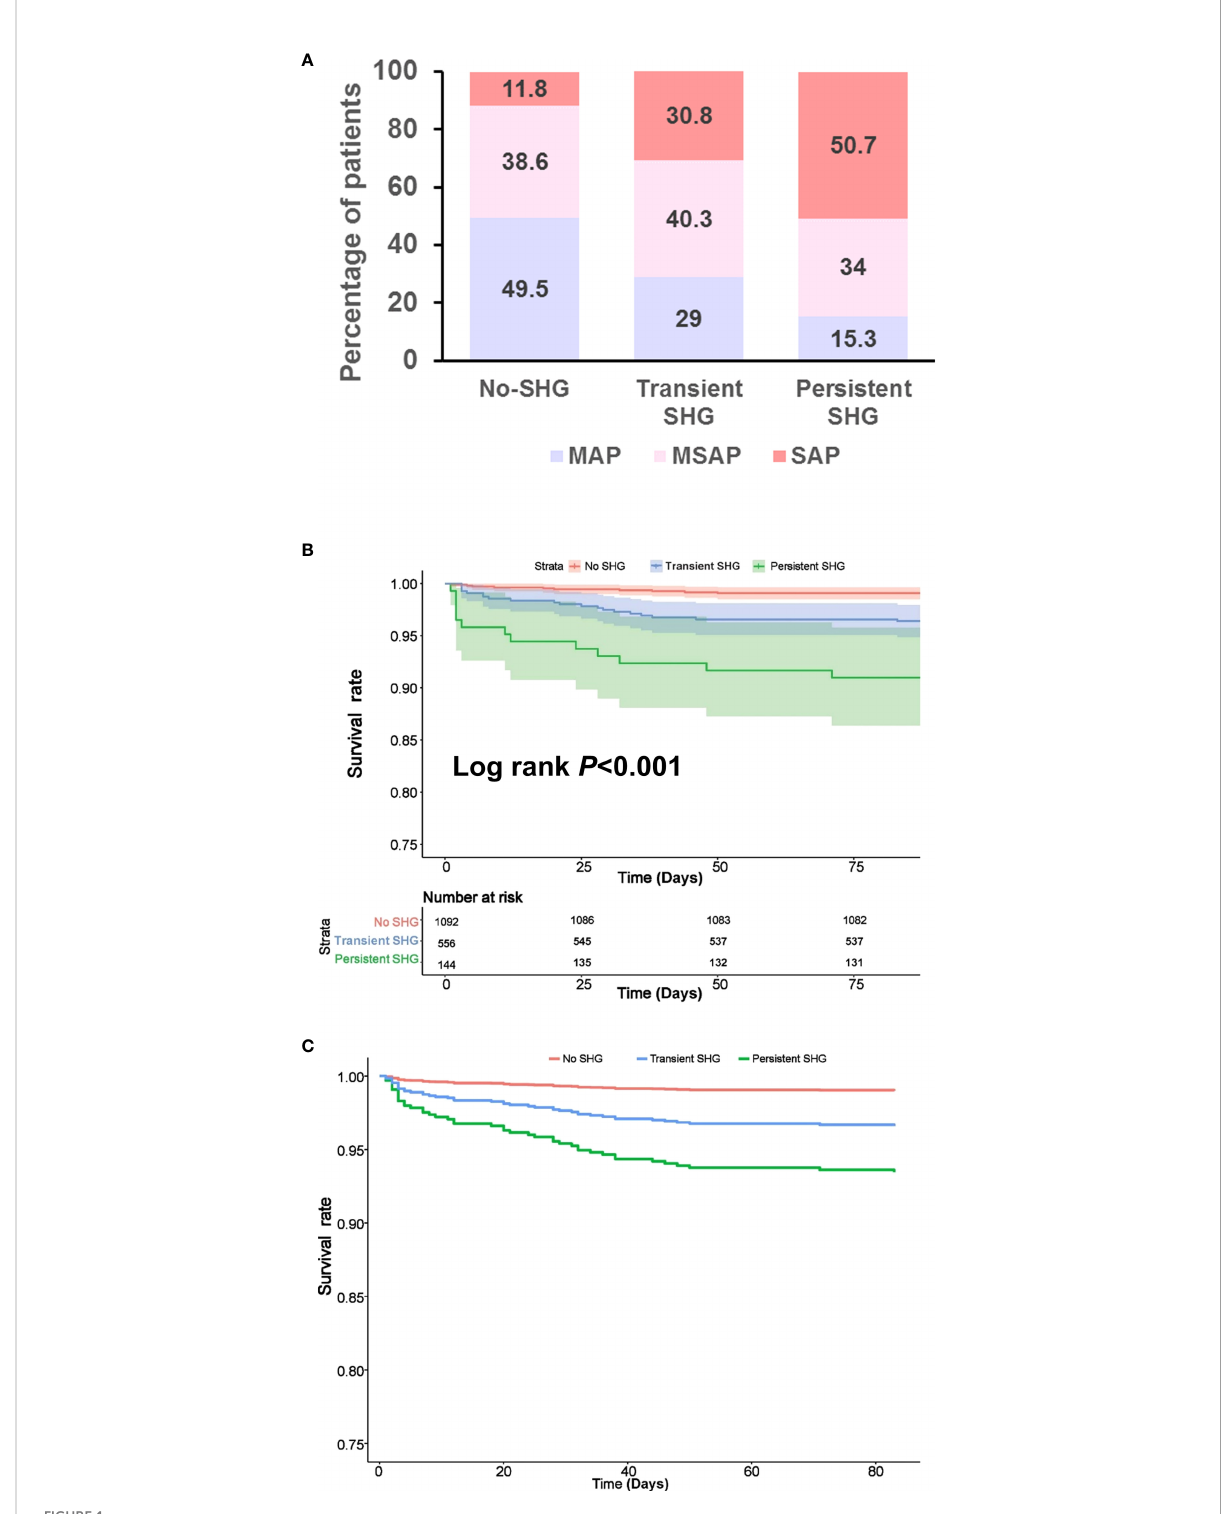
FIGURE 1 Features of patients strati fi ed by duration of stress hyperglycaemia during the fi rst week of admission. (A) Severity classi fi cation. (B) Kaplan – Meier survival curve. (C) Survival curve after adjusting for age, gender, BMI, Charlson comorbidity index, time to admission, referral status, biliary aetiology and admission TG levels. SHG, stress hyperglycaemia; MAP, mild acute pancreatitis; MSAP, moderately severe acute pancreatitis; SAP, severe acute